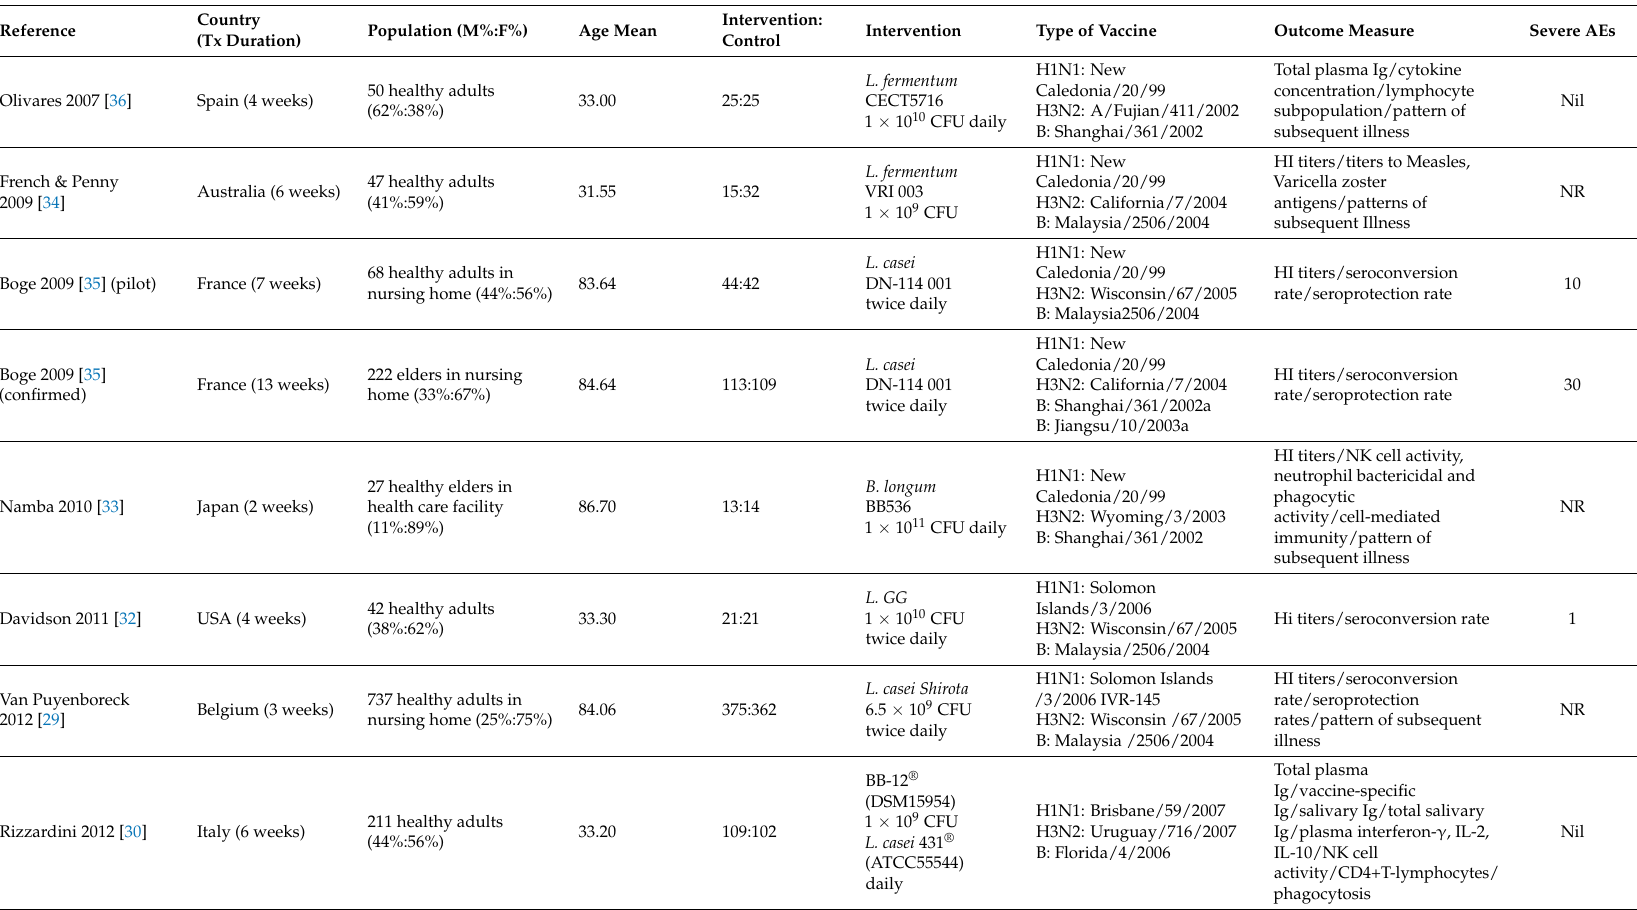
Table 1. Characteristics of randomized clinical trials using probiotics/prebiotics/synbiotics on Influenza-vaccinated